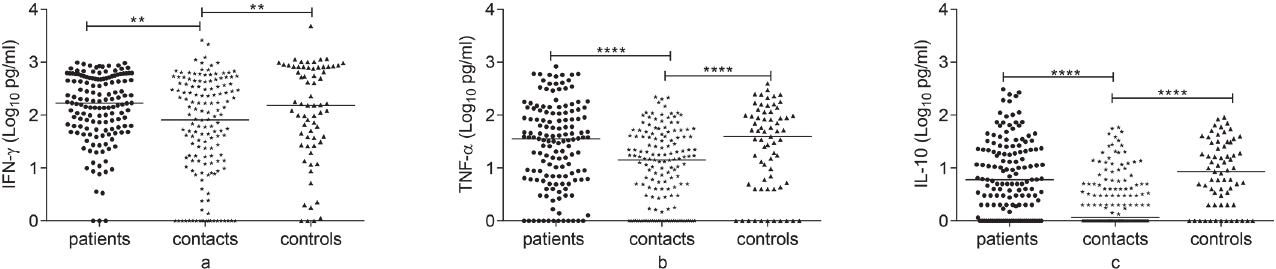
Fig 9. Comparison of baseline cytokine responses to E6C10 among groups. Baseline IFN- γ (a), TNF- α (b) and IL-10 (c) responses to E6C10 in patients, contacts and controls following whole blood stimulation for 48 hours. Filled circles represent patients, filled diamonds represent contacts and filled triangles represent controls. Results are individual responses and cytokine levels are expressed as log 10 pg/ml. Horizontal bars are medians. Kruskal-Wallis test with Dunn ’ s multiple comparisons was used to compare groups. ** p < 0.01, **** p < 0.0001.